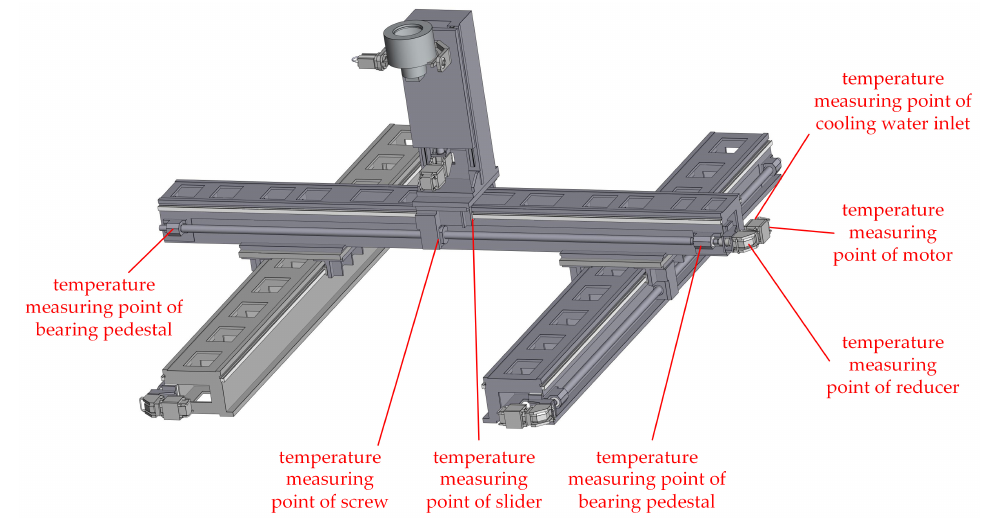
Figure 15. Temperature of the key components in a vacuum environment: ( a ) Motor side tempera- ture rise diagram; ( b ) Bearing set temperature rise diagram; ( c ) Nut temperature rise diagram; ( d ) Slider temperature rise diagram.